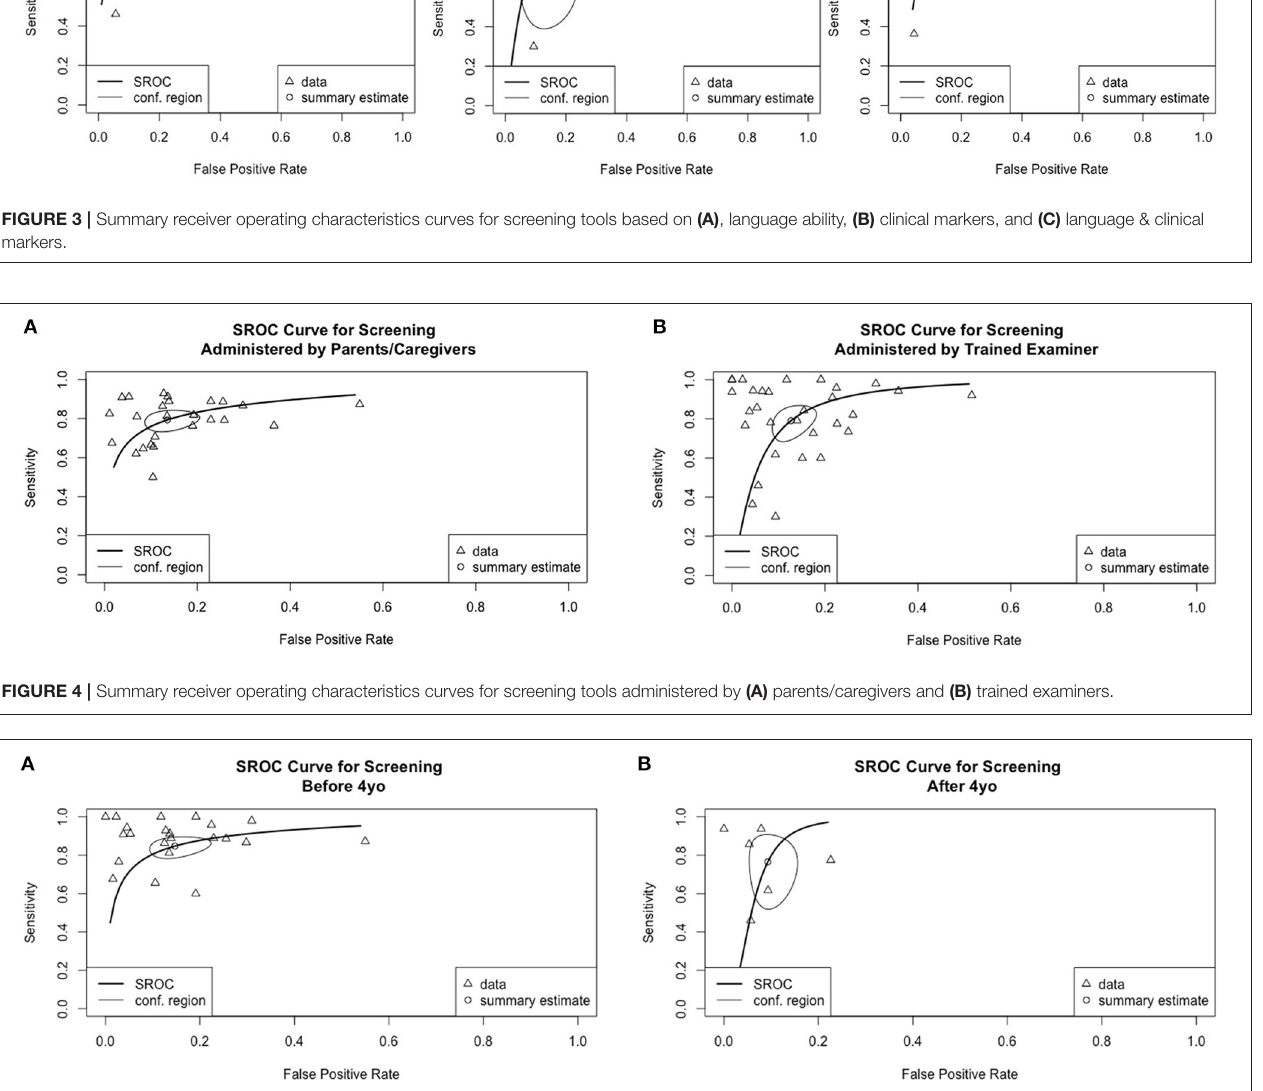
FIGURE 5 | Summary receiver operating characteristics curves for screening (A) under 4-year-old and (B) above